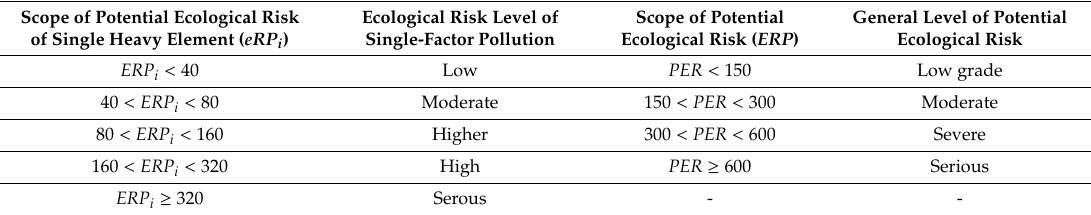
Table 7. Relationship among eRP i , ERP , and pollution level